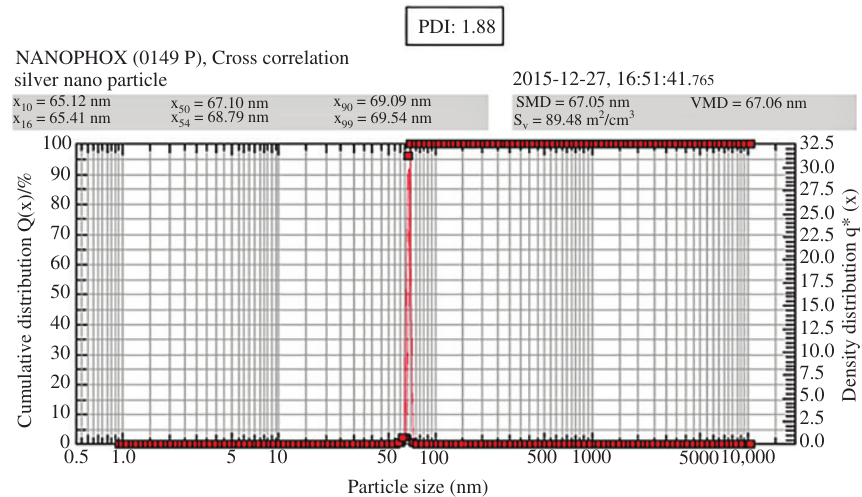
Figure 2: Dynamic light scattering (DLS) spectrum of silver nanoparticles